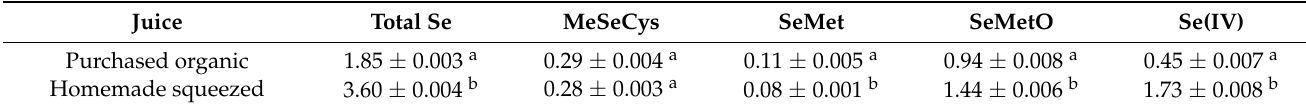
Table 1. Selenium species in beetroot juices (in mg L − 1